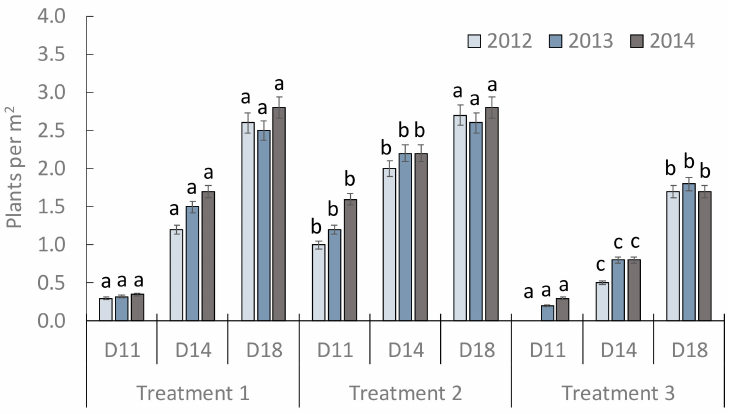
Figure 3. Plant count per square meter on days (D) 11, 14, and 18 after seeding for three treatments (T1, T2, and T3) in three growing seasons (2012, 2013, and 2014). Error bars on mean values denote the standard deviation. Different letters (between treatments and within the same year) indicate that mean values are significantly different at a 95% confidence interval. Treatments were Tc + DDO (T1), Rc + Tc + DDO (T2), and no Tc + DDO (T3), where Tc is turbo coulter blade, Rc is row cleaner, and DDO is double-disc